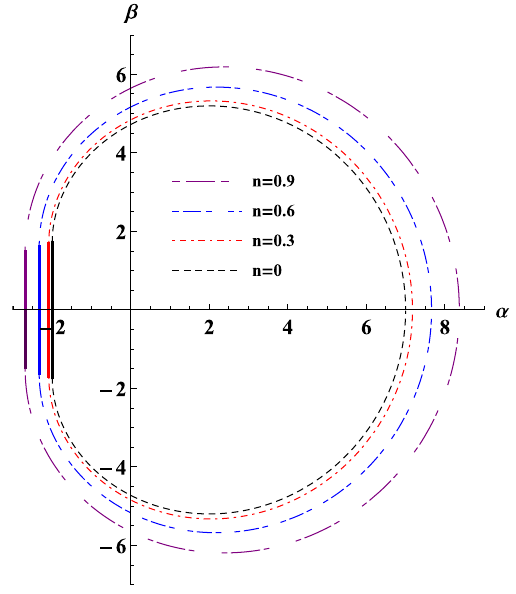
Fig. 2 The NHEKTN line in the KTN black hole shadow for different NUT charge n . Here, we set M =